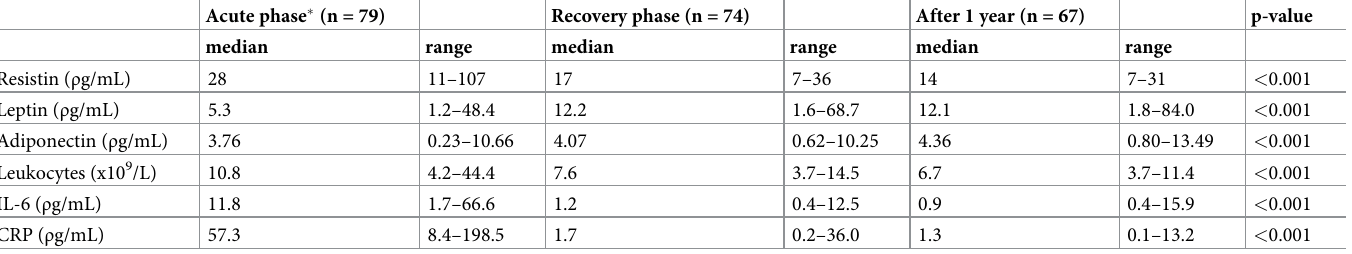
Table 2. The levels of plasma adipokines (resistin, leptin, adiponectin), and other markers of inflammation (leukocytes, plasma IL-6, CRP) in the acute phase of Puumala hantavirus infection compared to the recovery phase and one year after the infection. Acute phase � (n =